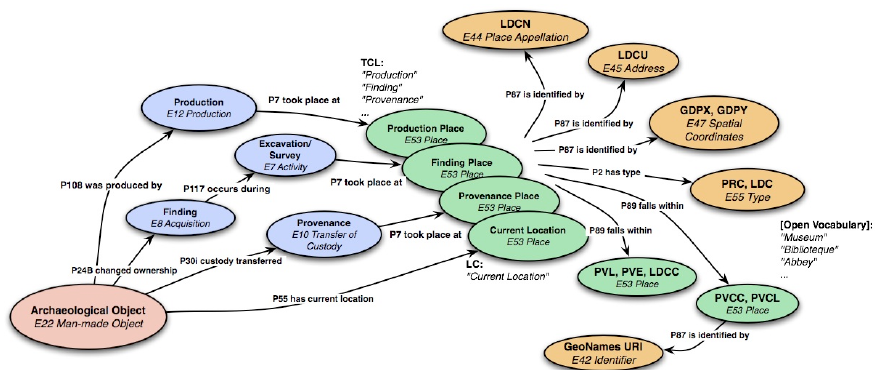
Fig. 1. CIDOC-CRM mapping of the ICCD-RA locations and places